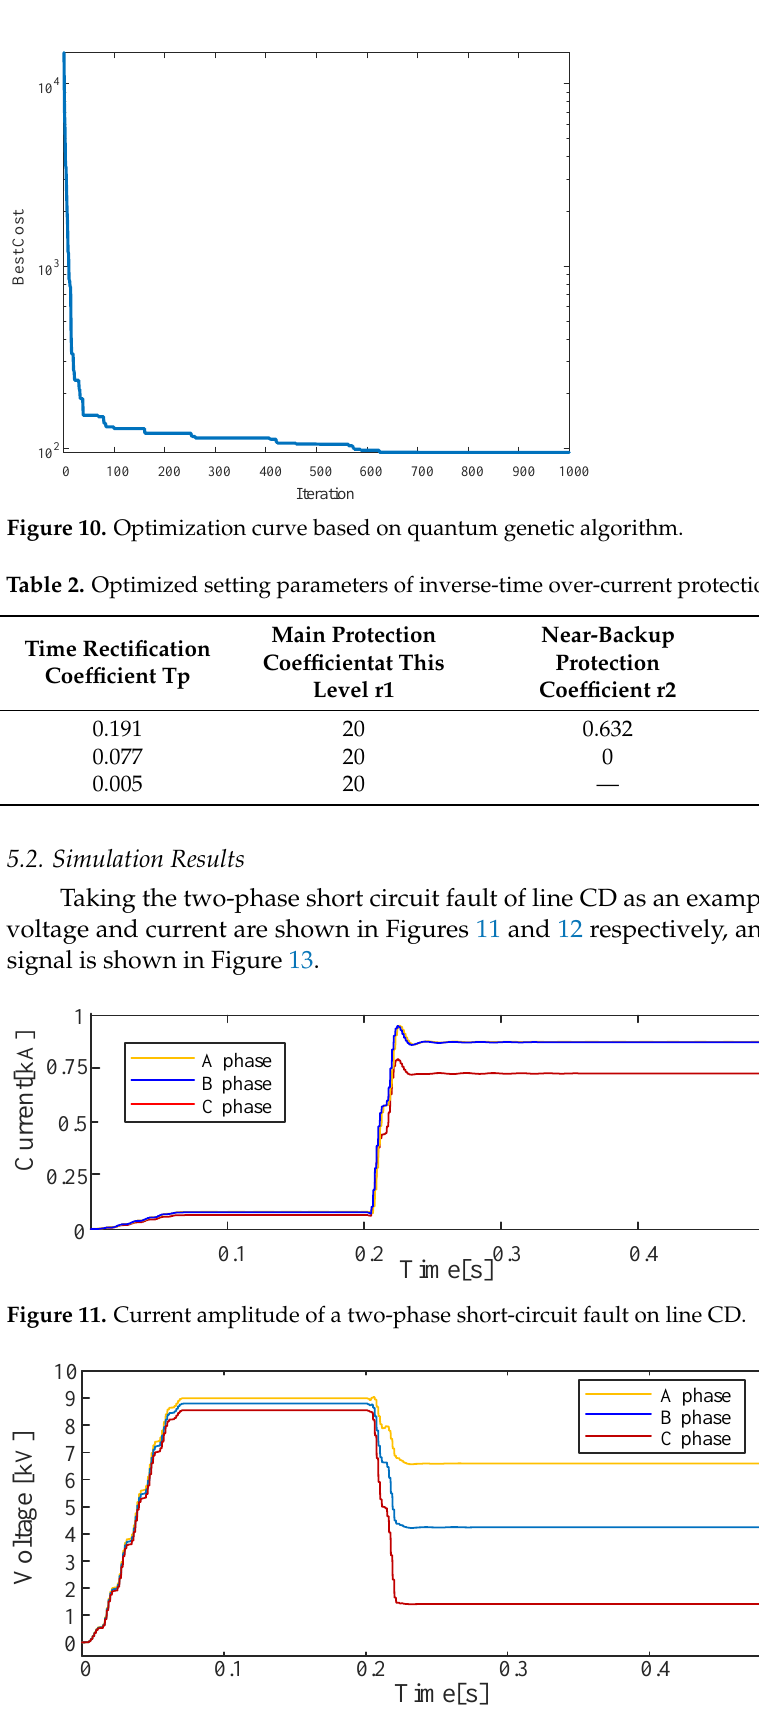
Figure 12. Voltage amplitude of a two-phase short-circuit fault on line CD.